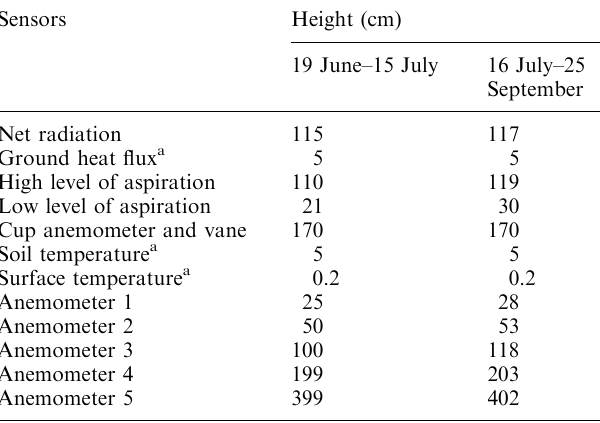
Table 4. Sensors’ location during the di(cid:128)erent phases of the 1997 WELSONS experiment. Locations are quite similar between both MGS, so this table only presents the values for the station CT. The two latter phases are joined (phase II and phase III in Table 2) because no change occurred during this whole period